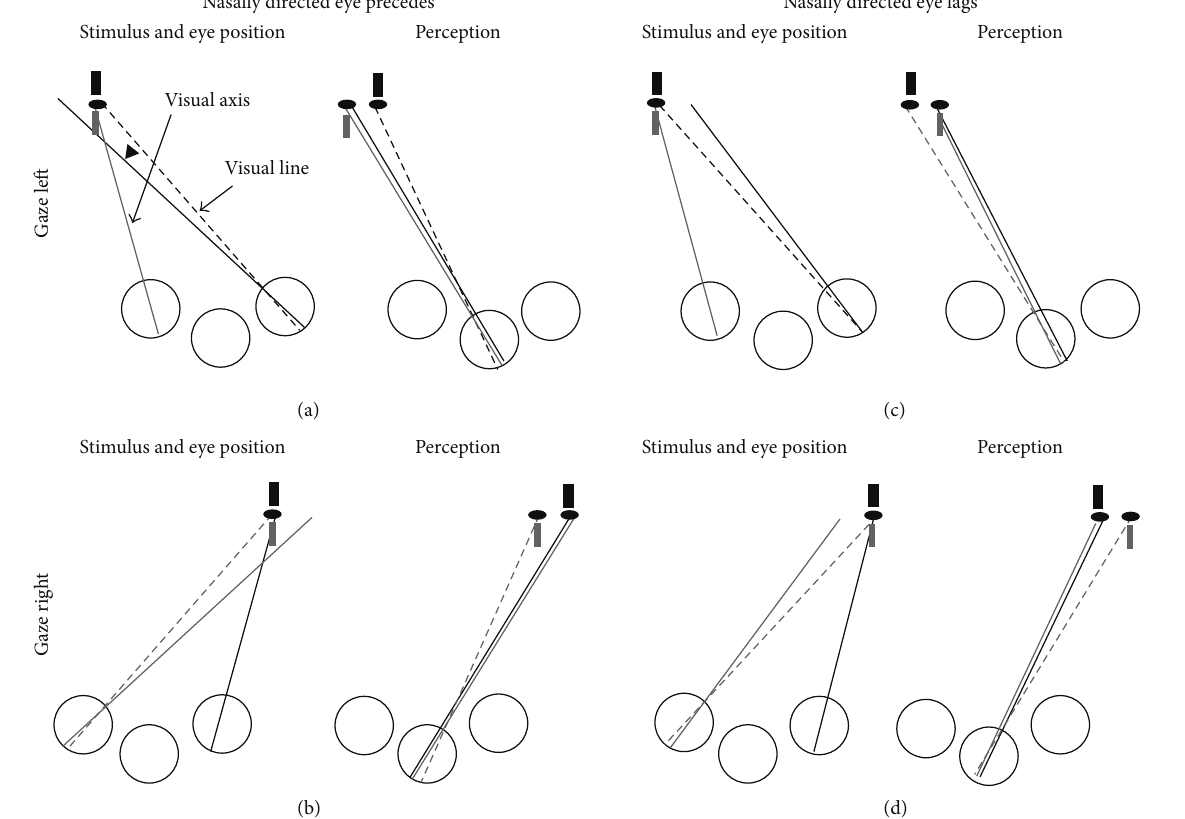
Figure 3: Predicted perceived Nonius/afterimage misalignments based on Wells [4] and Hering’s [2] laws of visual direction. In (a) the nasally directed eye precedes the temporally directed eye with associated perception of Nonius lines or afterimages; (b) same as (a) but for rightward gaze; (c) the nasally directed eye lags the temporally directed eye in leftward gaze with associated perception of Nonius lines or afterimages; (d) same as (c) but for rightward gaze. See text for more details.